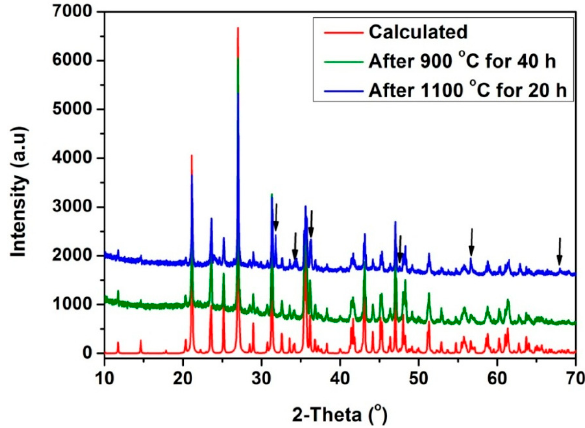
Figure 1. Calculated and experimental XRD of Ba 2 Zn(BO 3 ) 2 . The black arrows refer to ZnO (PDF#